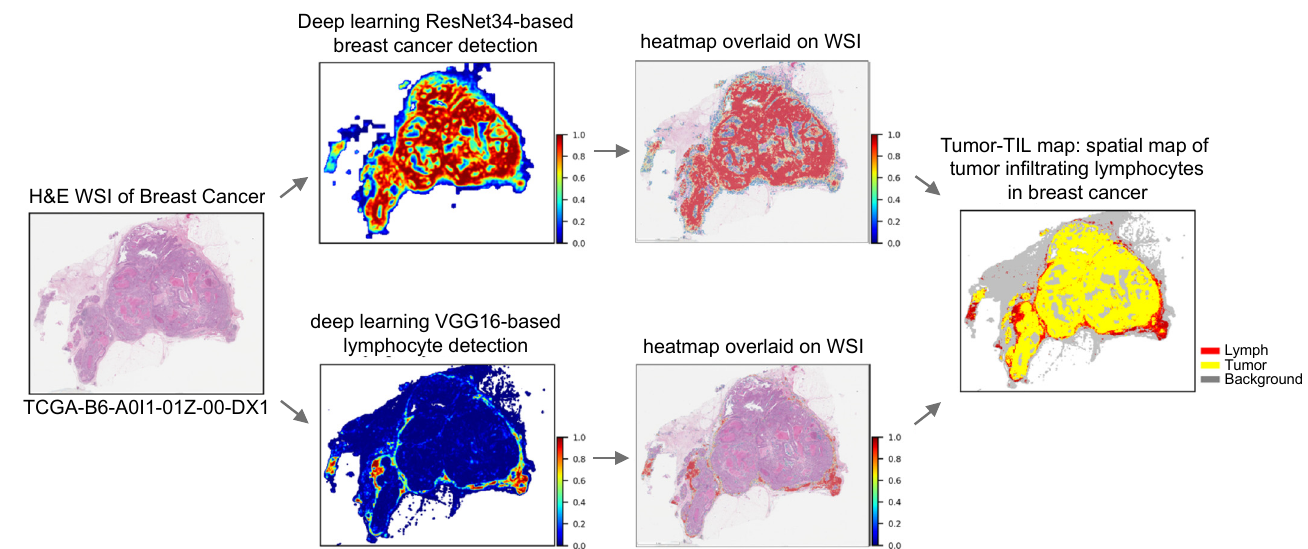
Figure 1. Machine learning and computer vision in computational pathology to spatially map tumor-infiltrating lymphocytes (TILs) in breast cancer. Top panels show tumor detection presented as a spatial probability heatmap to evaluate algorithmic performance (non-tumor tissue colored blue), which is then overlaid on the original H&E WSI. Bottom panels show automated lymphocyte detection presented as a spatial probability heatmap (non-lymphocyte tissue colored blue) and then overlaid on the original H&E WSI. Combining the outputs of tumor and lymphocyte detection generates Tumor-TIL maps to evaluate the abundance and spatial distribution of peritumoral and intratumoral TILs (tumor colored yellow, lymphocytes colored red, and background non-tumor/non- lymphocyte tissue colored gray). This Tumor-TIL map shows the presence of peritumoral TILs with a paucity of intratumoral TIL infiltrates. Image: BRCA TCGA-B6-A0I1-01Z-00-DX1, high-grade breast cancer; cancer detection with ResNet model; lymphocyte detection with VGG16 model.